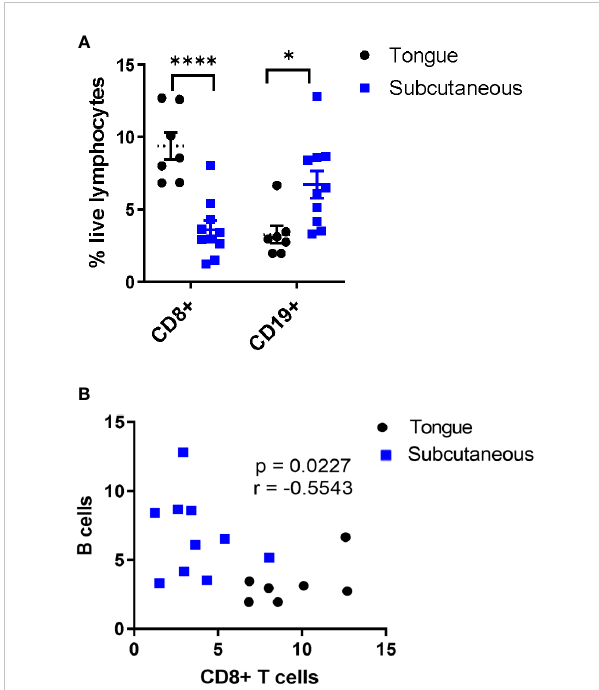
FIGURE 1 Inverse correlation between B cell and CD8+ T cell in fi ltration in PD-1 blockade-resistant tumors. Flow cytometry was utilized to analyze tumor-in fi ltrating lymphocytes present in HPV+ tumors between mice with tongue tumors (PD-1 blockade sensitive) (n = 7) or subcutaneous tumors (PD-1 blockade resistant) (n = 10). Among total live lymphocytes, CD8+ T cells and CD19+ B cells were quanti fi ed (A) . Signi fi cant differences between groups were determined by two-way ANOVA test ****p< 0.00001, *p < 0.01 (A) . The graph represents the correlation between the frequency of CD19+ B cells and CD8+ T cells in tumors (n=17) (B) . Results depict pooled data from 2